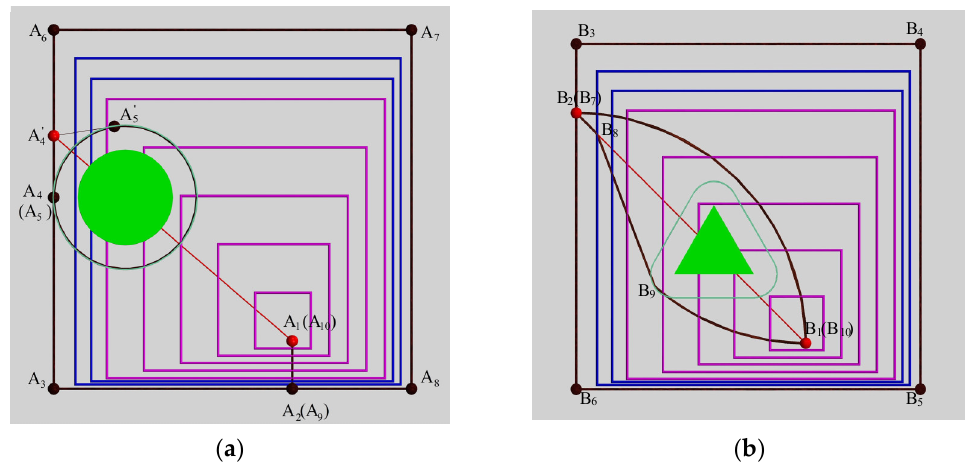
Figure 6. Motion path of the end-effector. ( a ) 2D path of end-effector of the manipulator in obs1; ( b ) 2D path of end-effector of manipulator in obs2. 2D path of end-effector of manipulator in